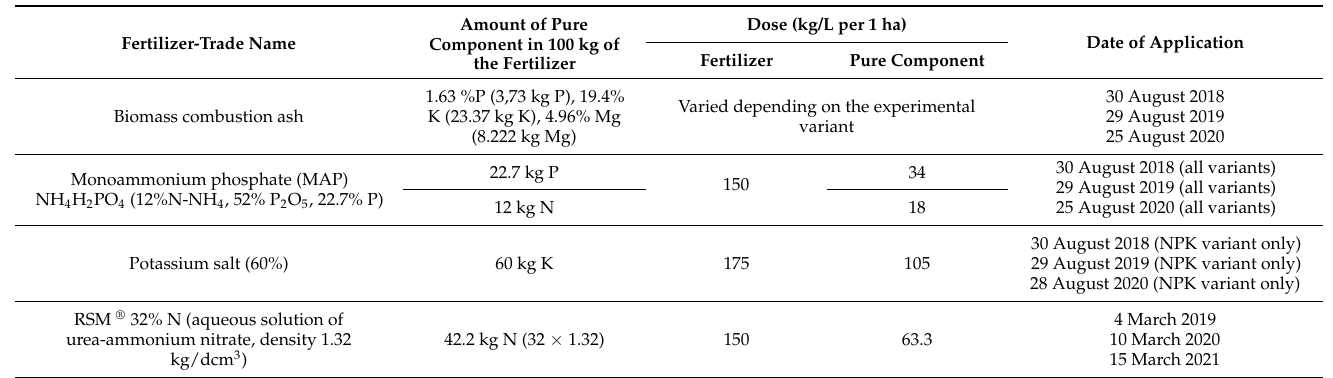
Table 1. Fertilizers used in the field experiment in 2018–2021.